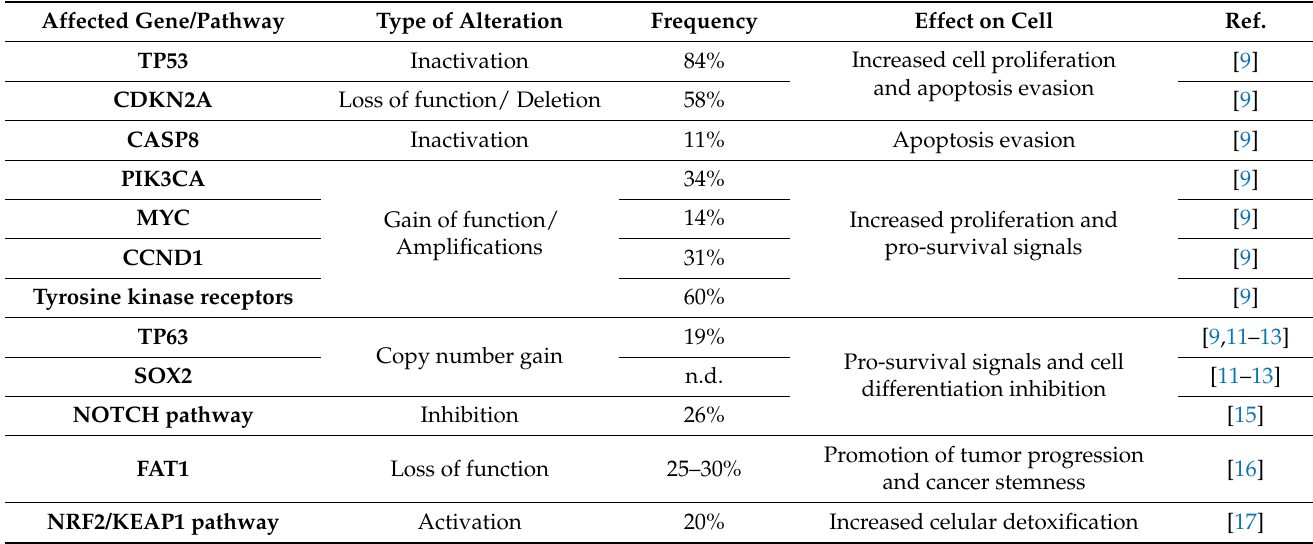
Table 1. Altered genes or pathways presented in HNSCC and their cellular effects.